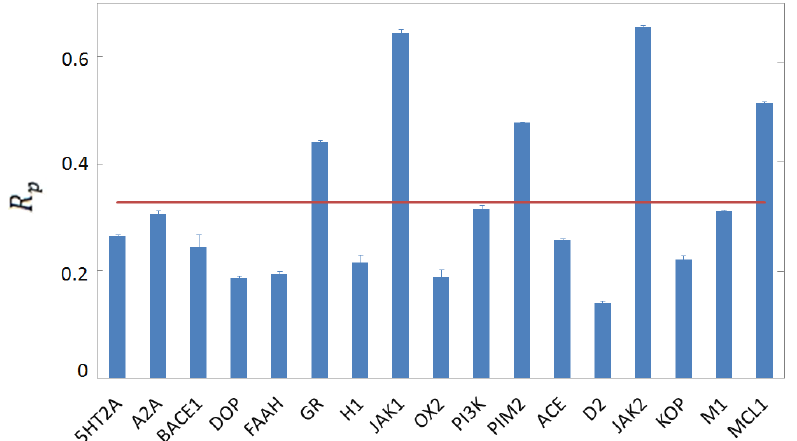
Figure 6. Accuracy scores R p for binding affinity affinity predictions for 17 FCNN SF’s in per-target vertical tests. Each SF is trained on the computer-generated database excluding the complexes made from the protein indicated on the horizontal axis, and tested on the excluded complexes. The horizontal red line indicates the average